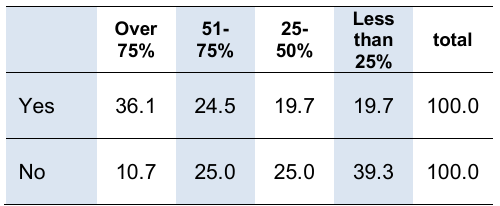
Table 11- networks and contribution to earning n =